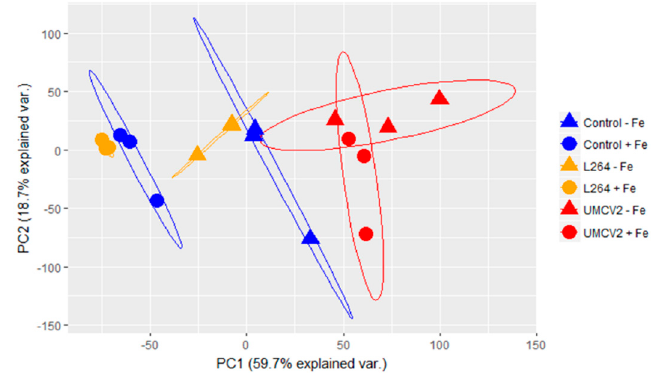
Figure 3. Principal component analysis (PCA) obtained from DLI-ESI mass spectra of Medicago truncatula leaves under Fe-sufficient and -deficient conditions and following exposure to microbial volatiles. Blue indicates control plants, orange represents plants exposed to volatiles emitted by L264 strain, and red shows the plants exposed to volatiles from A. agilis UMCV2. Circles ( Ο ) and triangles ( Δ ) indicate Fe sufficiency and deficiency, respectively. The ellipses represent 95% confidence intervals. Differences between groups were compared with a PERMANOVA test ( p ˂ 0.001).